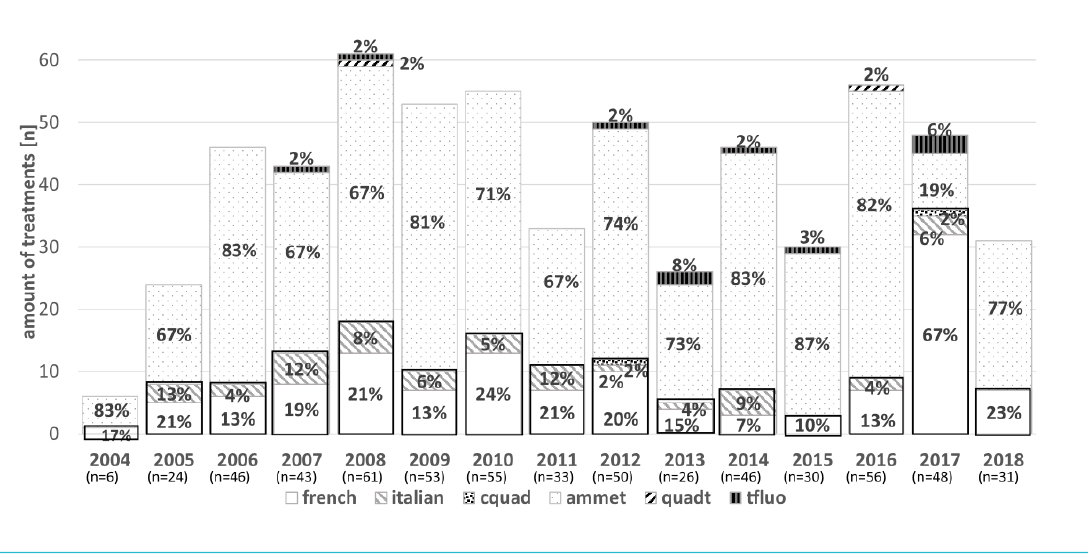
Figure 2: Different first-line Helicobacter pylori eradication regimens in over the years.french: PPI-amoxicillin-clarithromycin*; italian: PPI- metronidazole-clarithromycin*; cquad: PPI-clarithromycin-amoxicillin-metronidazole*; ammet: PPI-amoxicillin-metronidazole**; quadt: PPI-